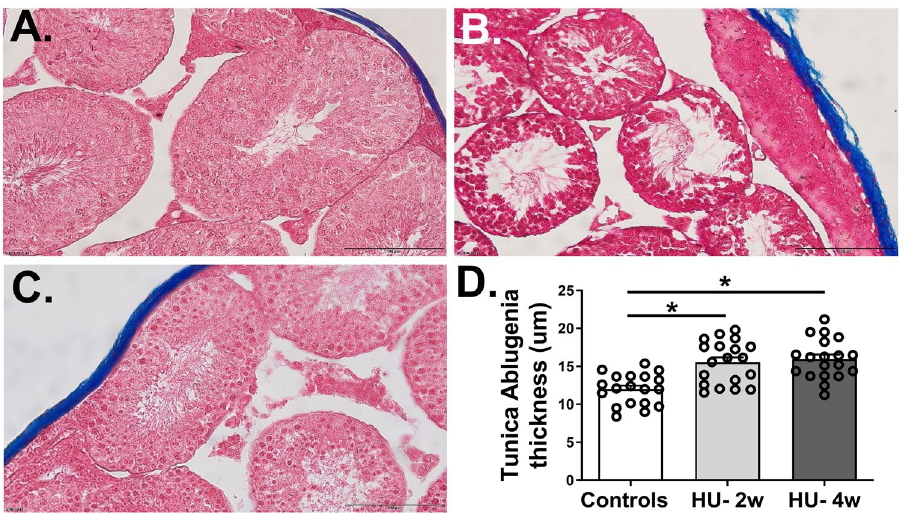
Figure 4. Histopathological features of tunica albuginea of testes stained with Masson’s trichrome from ground- based controls ( A ) and HU mice suspended for two ( B ) and four ( C ) weeks. The image analysis shows the thickness of the tunica albuginea ( D ). Data is represented as Mean ± SEM (n = 19 images and 8–12 mice/group). All images were taken at 40 × magnification, One-way analysis of variance, *p < 0.05.